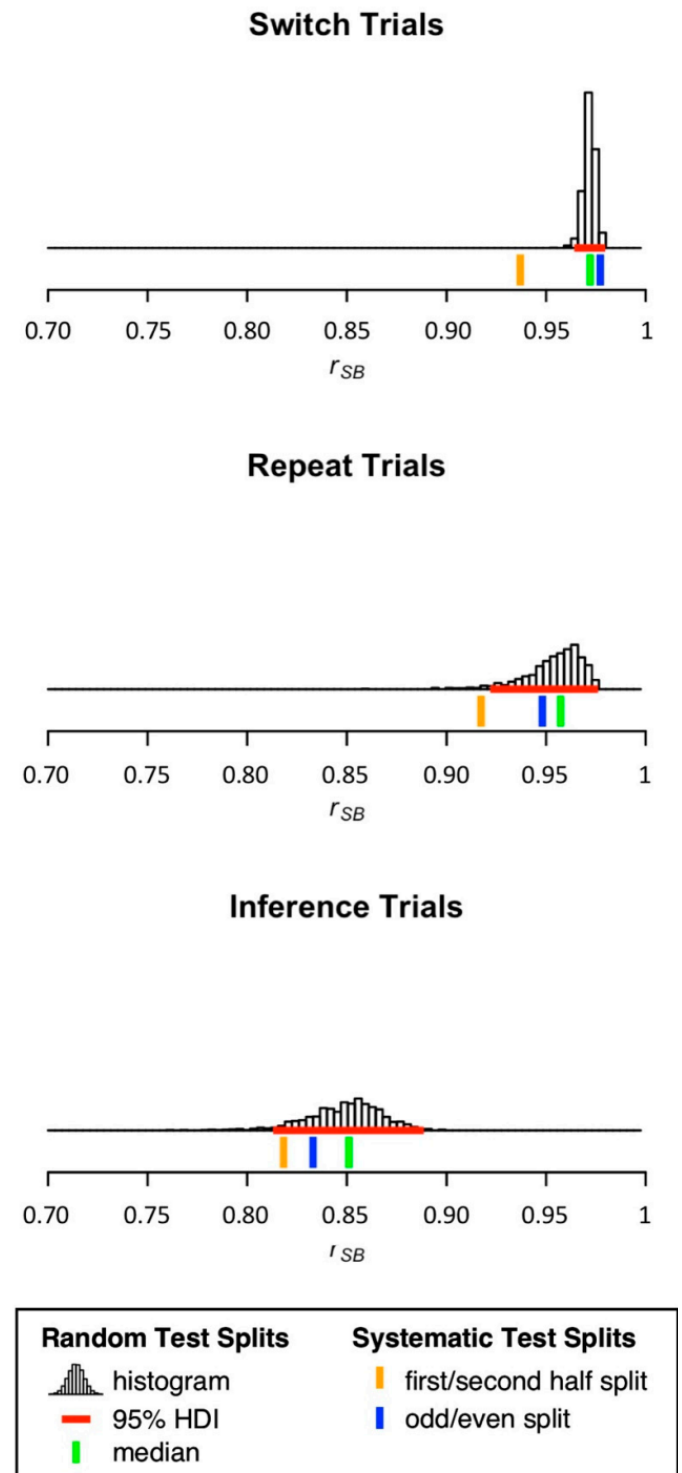
Figure 3. Distribution of split-half reliability estimates for mean RT on switch, repeat, and inference trials. 95% HDI = 95% highest density